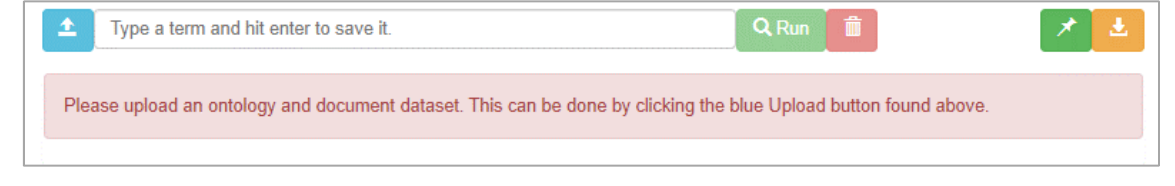
Figure 7. The initial state of ONTSI.